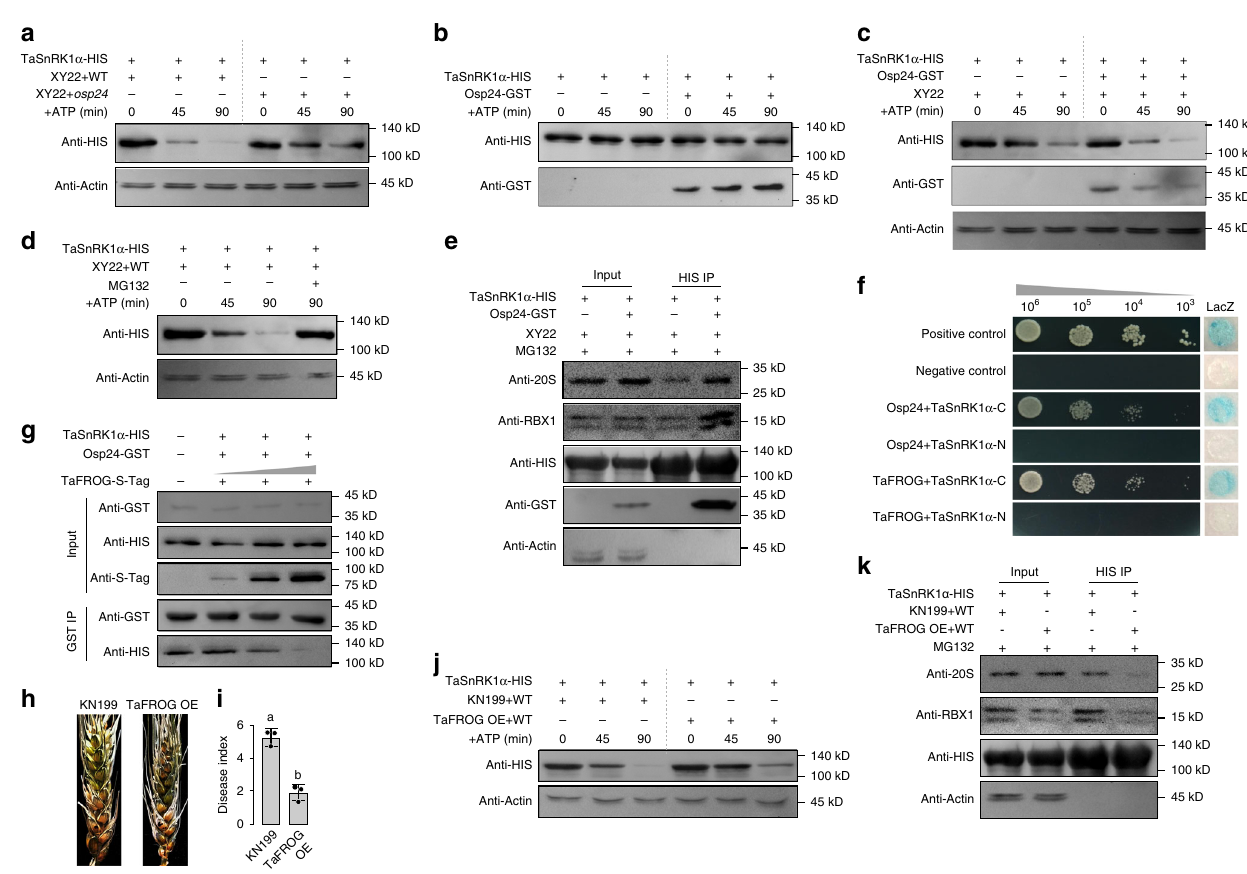
Fig. 4 Roles of Osp24 and TaFROG in modulating TaSnRK1 α stability. a Western blots of the mixtures of equal amount of TaSnRK1 α -HIS and total proteins isolated from wheat heads of cultivar Xiaoyan22 inoculated with the wild type PH-1 (XY22 + WT) or osp24 mutant (XY22 + osp24 ) incubated for the indicated times after the addition of 10 mM ATP were detected with the anti-HIS or anti-actin (loading control) antibody. b Western blots of the mixtures of equal amount of TaSnRK1 α -HIS and Osp24-GST incubated for the indicated times were detected with an anti-HIS or anti-GST antibody. Degradation of TaSnRK1 α -HIS by Osp24 was not observed. c Recombinant TaSnRK1 α -HIS and Osp24-GST proteins were incubated with equal amounts of total proteins isolated from wheat head (XY22) in the presence of 10 mM ATP and used for western blot analyses with the indicated antibodies. d Degradation of TaSnRK1 α by total proteins isolated from wheat head inoculated with PH-1 (XY22 + PH-1) was inhibited by proteasome inhibitor MG132. e Western blots of the indicated protein mixtures (Input) or proteins co-puri fi ed with TaSnRK1 α -HIS from these protein mixtures (HIS IP) were detected with the anti-20S, anti-RBX1, anti-HIS, and anti-GST antibodies. f Yeast transformants expressing the indicated Osp24 or TaFROG bait construct and prey constructs of the N-terminal (1 – 266 aa) or C-terminal (267 – 499 aa) region of TaSnRK1 α (TaSnRK1 α -N and TaSnRK1 α -C) were assayed for growth on SD- Trp-Leu-His plates and LacZ activity. g Western blots of the indicated protein mixtures (Input) or proteins co-puri fi ed with Osp24-GST from these mixtures (GST IP) were detected with the anti-GST, anti-HIS, or anti-S-tag antibody. The amount of TaSnRK1 α -HIS proteins co-immunoprecipitated with Osp24-GST was reduced by the addition of increasing concentrations of TaFROG-S-tag proteins. h Representative wheat heads of cultivar KN199 and its TaFROG overexpressing transgenic line (TaFROG OE) infected with PH-1 were photographed at 8 dpi. i Mean and standard deviation (SD) of the disease index of PH-1 on the labeled wheat lines were estimated from three independent experiments ( n = 3) with at least 10 infected wheat heads in each replicate. Different letters indicate signi fi cant differences based on ANOVA analysis followed by Duncan ’ s multiple range test ( P = 0.05). j Cell-free degradation assays with recombinant TaSnRK1 α -HIS incubated with equal amounts of total proteins isolated from wheat heads of KN199 and TaFROG OE transgenic lines infected by PH-1 for the indicated time after addition of 10 mM ATP. k Western blots of the indicated protein mixtures (Input) or proteins co-puri fi ed with TaSnRK1 α -HIS from these protein mixtures (HIS IP) were detected with the anti-20S, anti-RBX1, and anti-HIS antibodies. For a , c , d , e , j , and k , detection with an anti-actin antibody was used as the